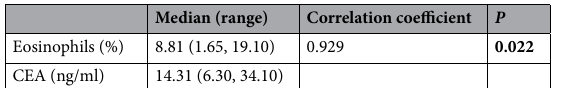
Table 2. The relationship between CEA and eosinophils in this